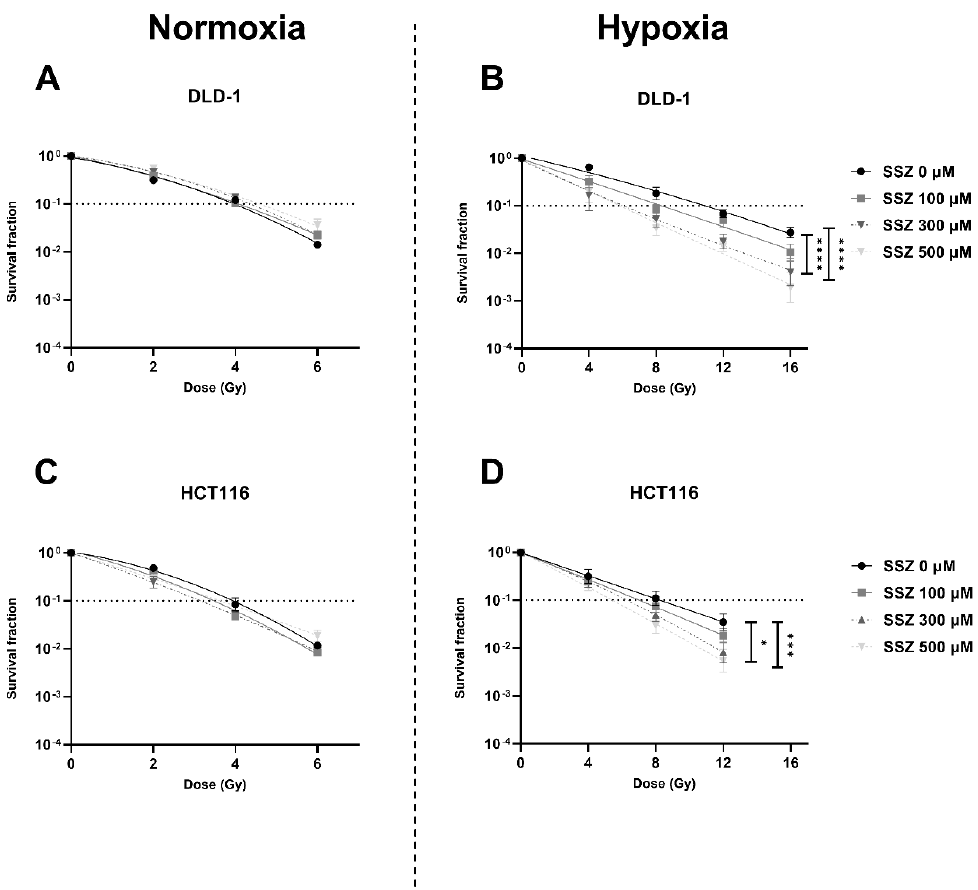
both cell lines, with enhancement ratios (ER) of 1.9 in DLD-1 cells and 1.6 in HCT116 cells (Figure 2B,D) [23]. SSZ overcame hypoxic radioresistance but did not alter the intrinsic radioresistance of both cell lines.